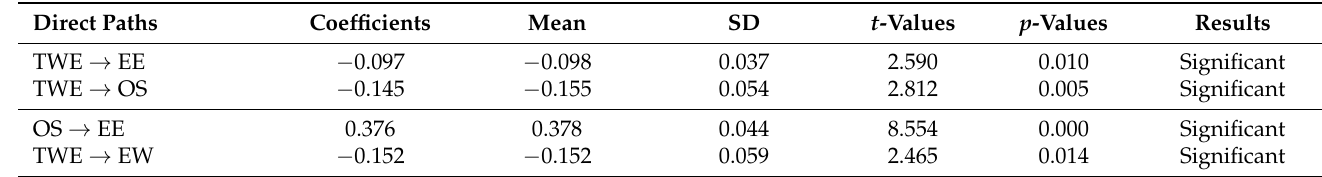
Figure 2. Path coefficients of the research model. Table 4. Direct and indirect